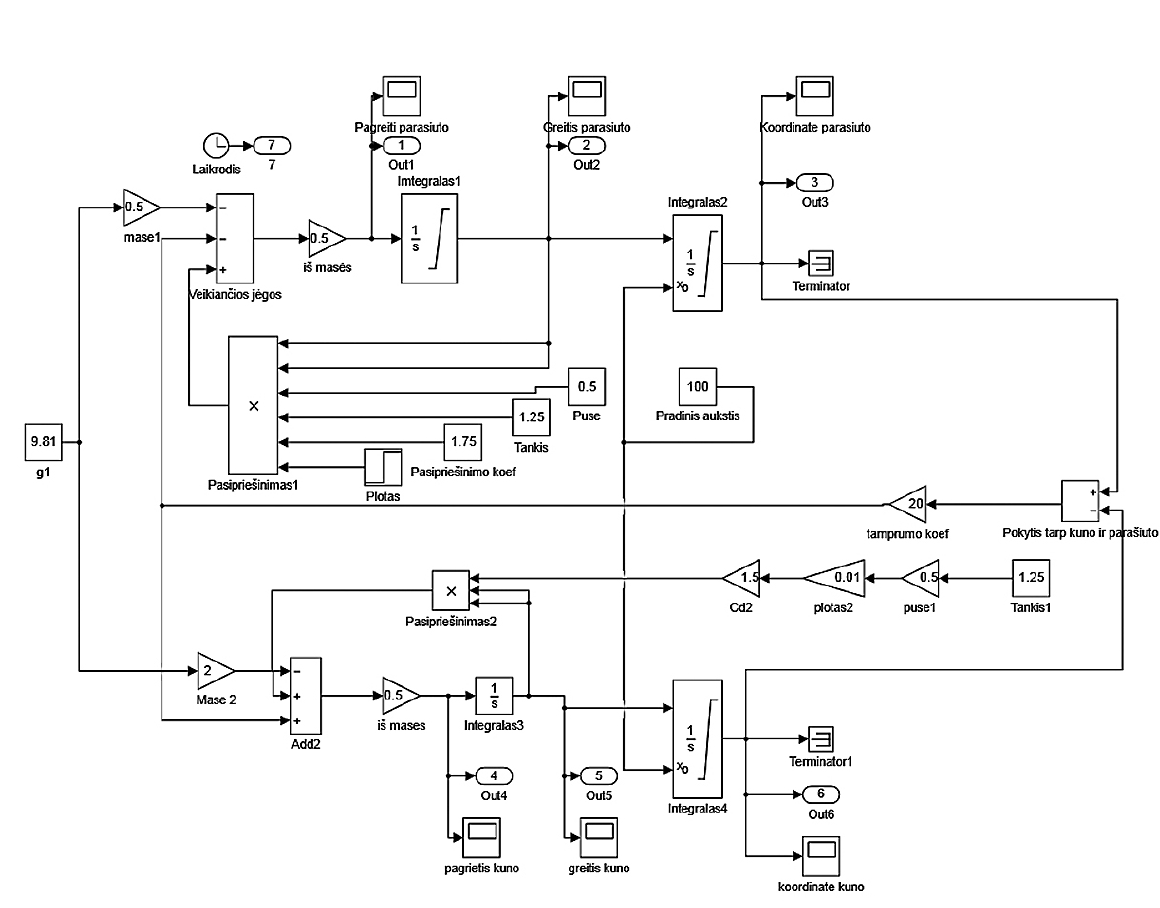
Fig. 8. Mathematical model of cargo